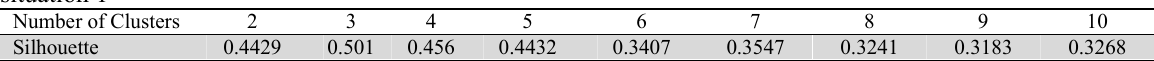
Comparison of the silhouette values for different numbers of clusters in K-means algorithm for scenario 8 in situation 1 Number of Clusters